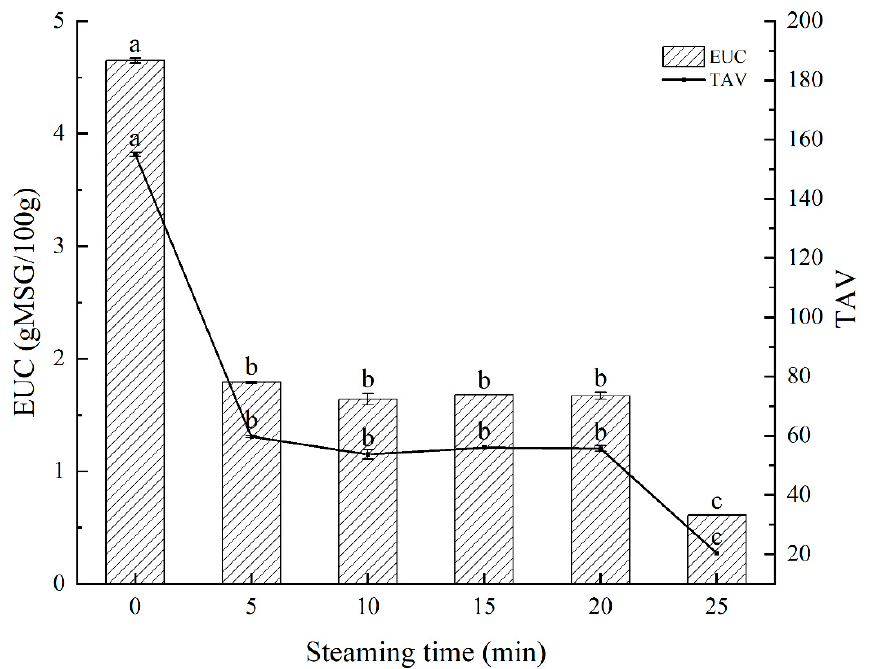
Figure 1. Comparison of EUC and TAV in swimming crab meat during steaming. Different letters are significantly different at p <